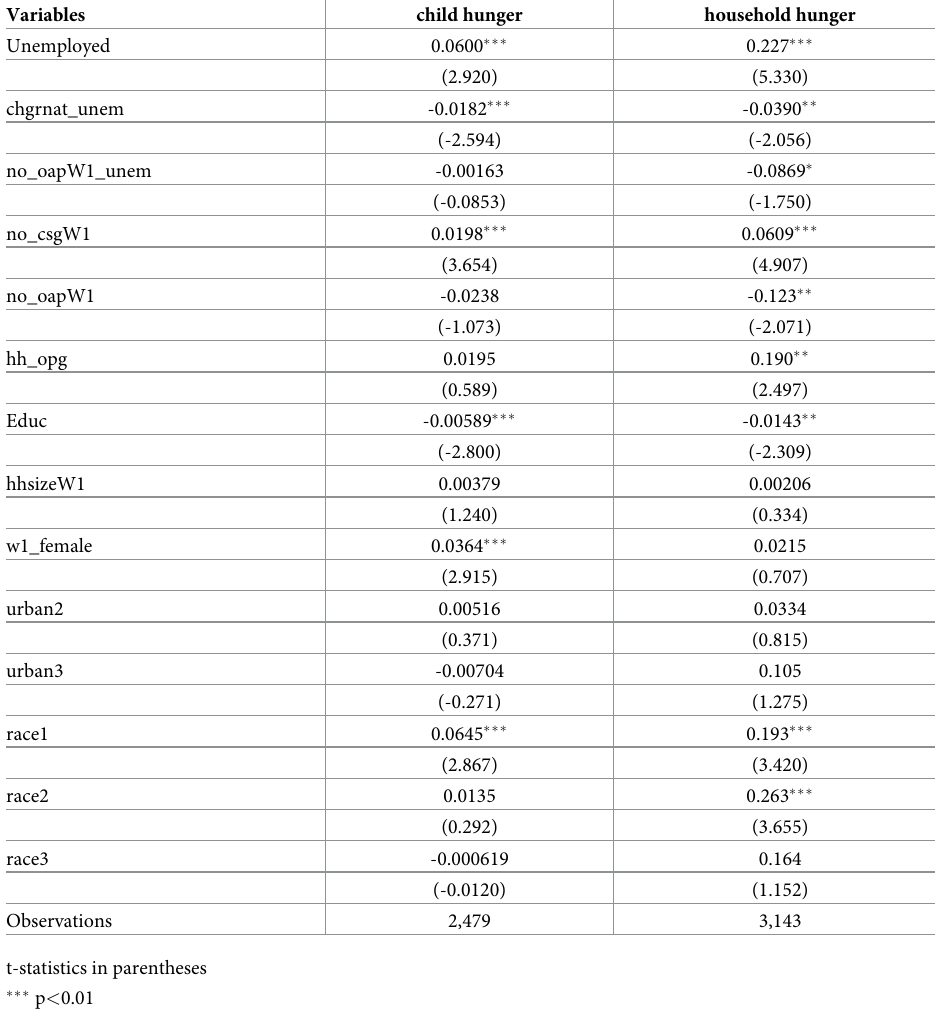
Table 2. Marginal effect estimates of probit model food